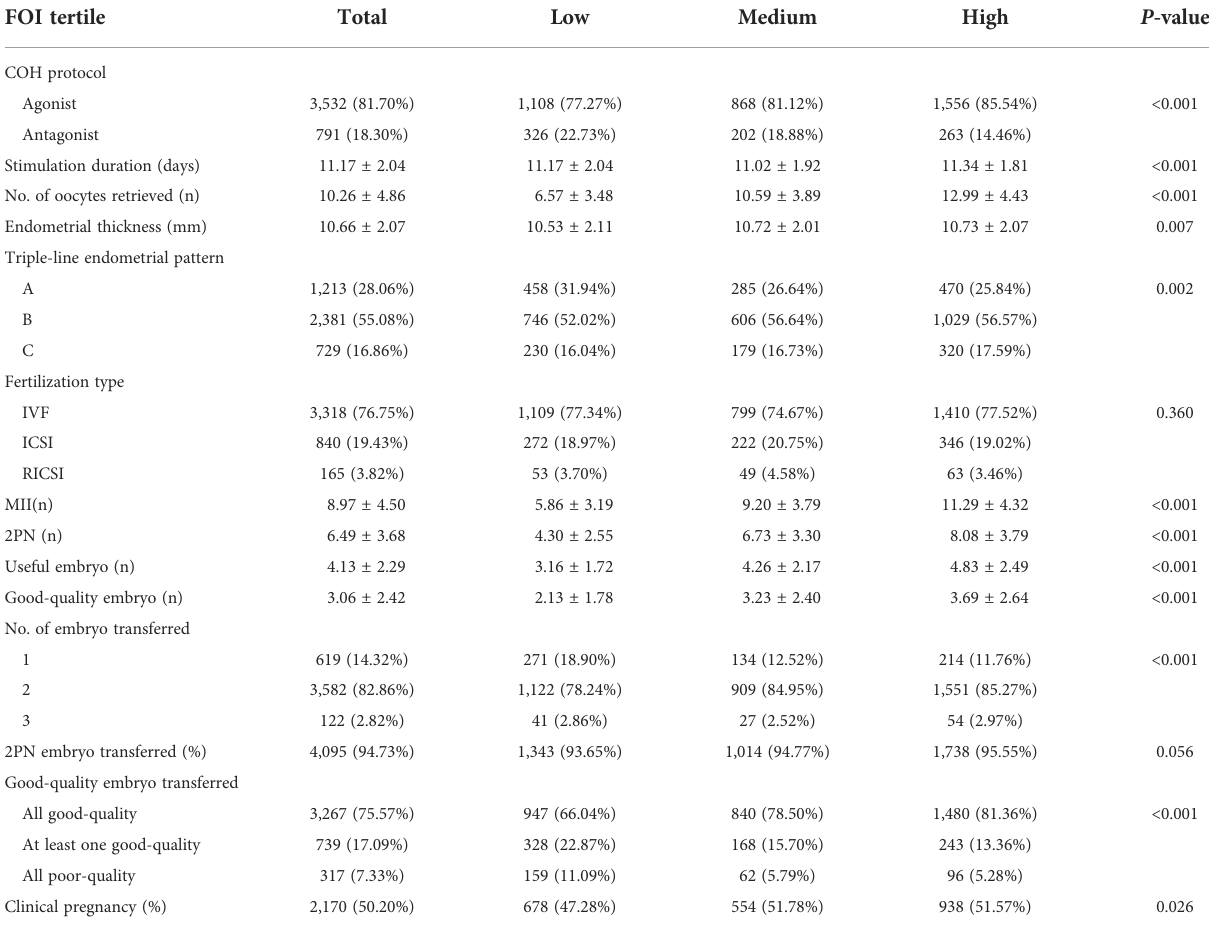
TABLE 2 IVF/ICSI outcomes of studied cycles strati fi ed by FOI. FOI tertile